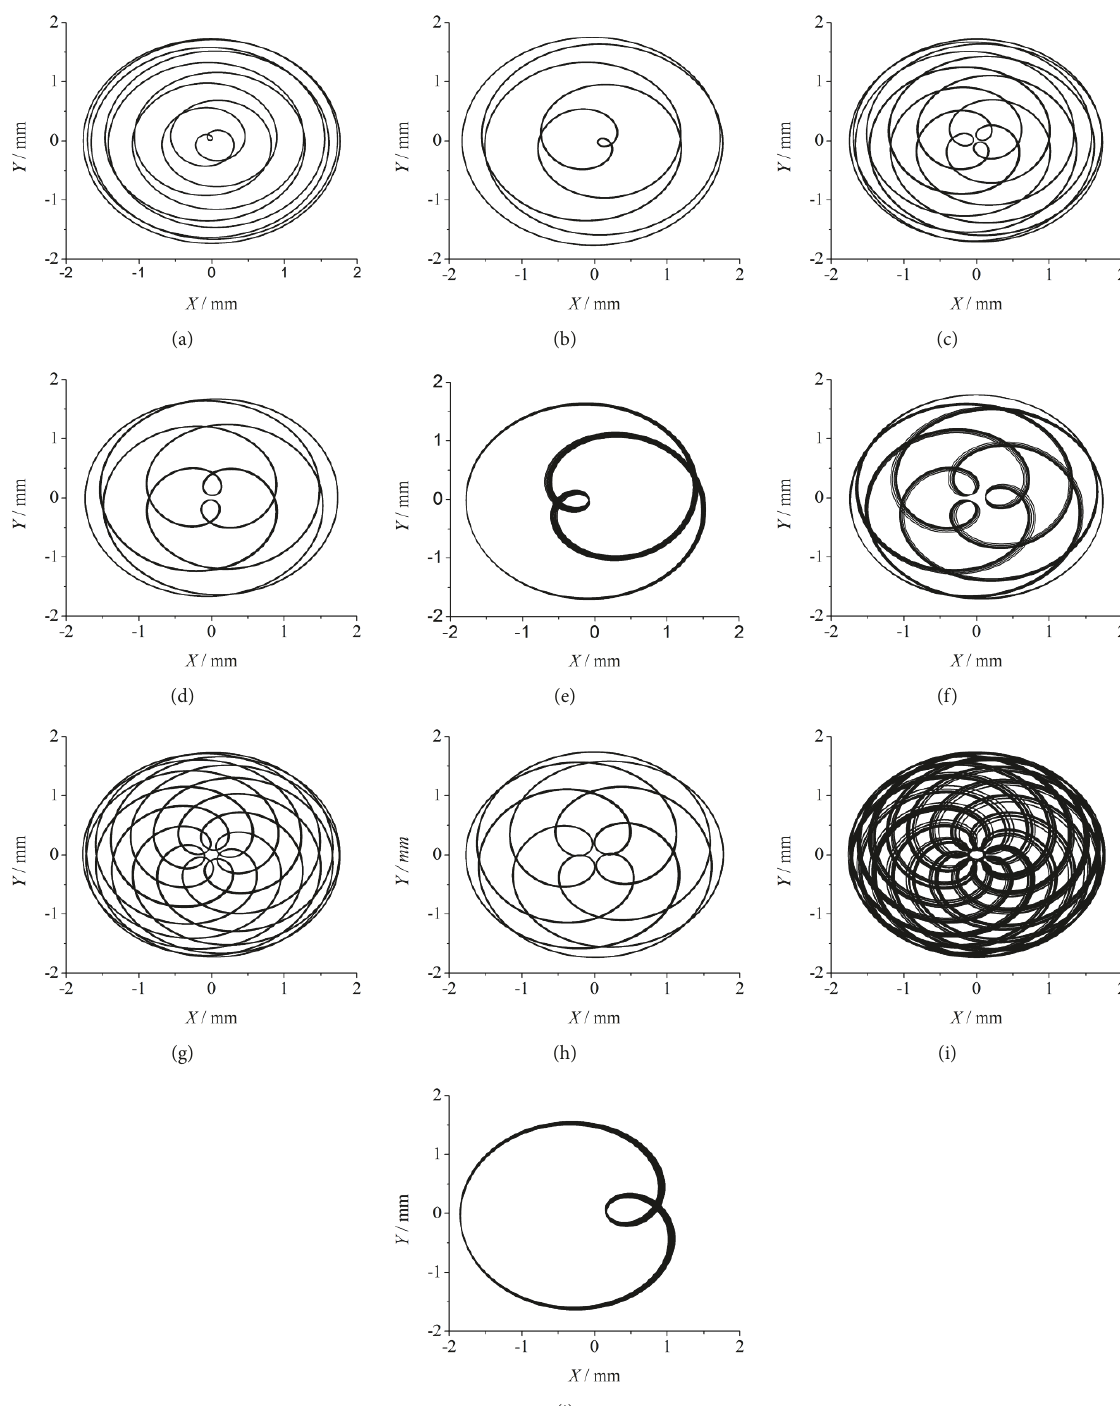
Figure 9: The movement track of the frame with multifrequency controlled synchronization on the situations from 𝑛 = 1.1 to 𝑛 = 2 . (a) is the situation of 𝑛 = 1.1 and (j) is the situation of 𝑛 = 2